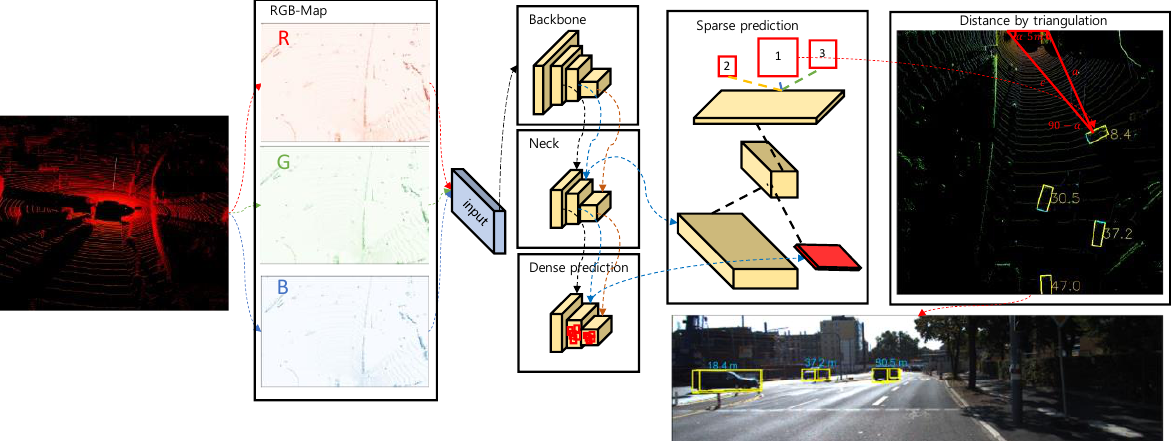
Figure 3. Overview of the distance extraction from the LiDAR data. First, point cloud data are classified according to height, intensity, and density. Then, this data is fed into the convolutional network (YOLOv4) to obtain bounding 2D boxes on the BEV map. Subsequently, as described in Section 3.4, 2D boxes are projected as 3D boxes onto the image (1,2 and 3 are the detected objects on the image).